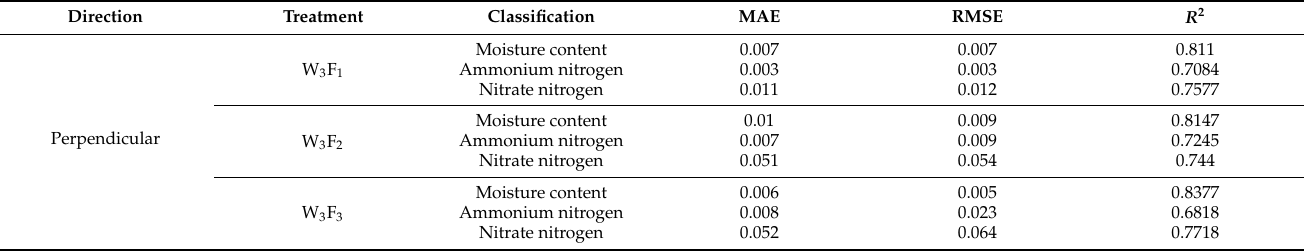
Table 6. Error analysis of the measured and predicted values of soil volumetric water content, ammonium nitrogen, and nitrate